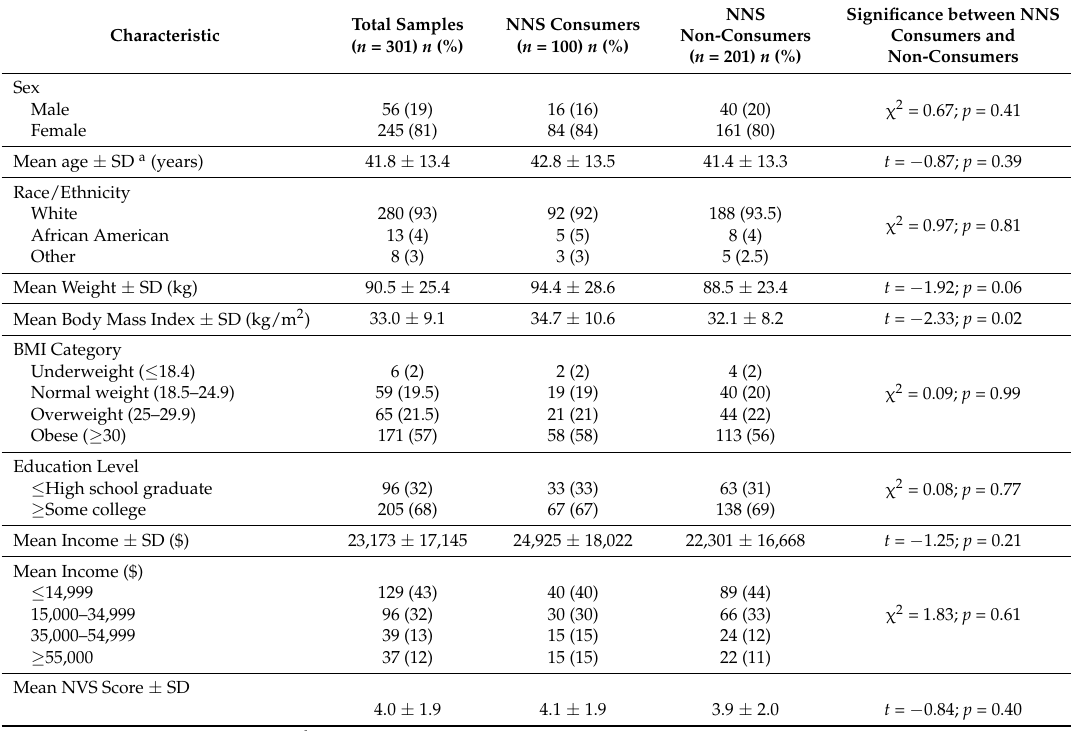
Table 2. Participant demographic characteristics by total sample and by non-nutritive sweetener (NNS) consumer